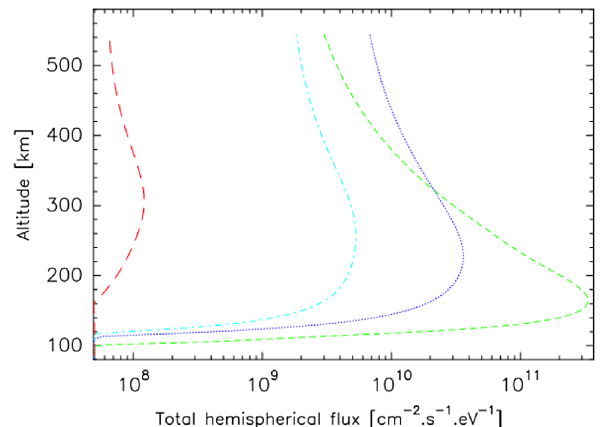
Fig. 4. Hemispheric stationary fl ux deduced from the kinetic Boltzmann equation integrated over all the angles. Green: 1 eV; dark blue: 10 eV; light blue: 20 eV; red: 50